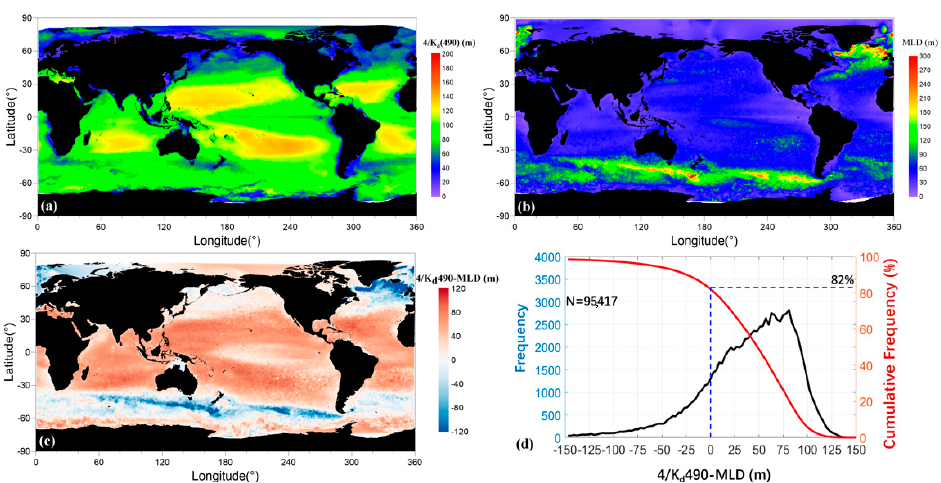
Figure 5. Distribution of the maximum detectable depth for oceanographic lidar ( a ), the upper mixed layer depth (MLD) ( b ), the difference between the maximum detection depth and the MLD ( c ), and the frequency distribution of the difference between the maximum detection depth and the MLD ( d ).